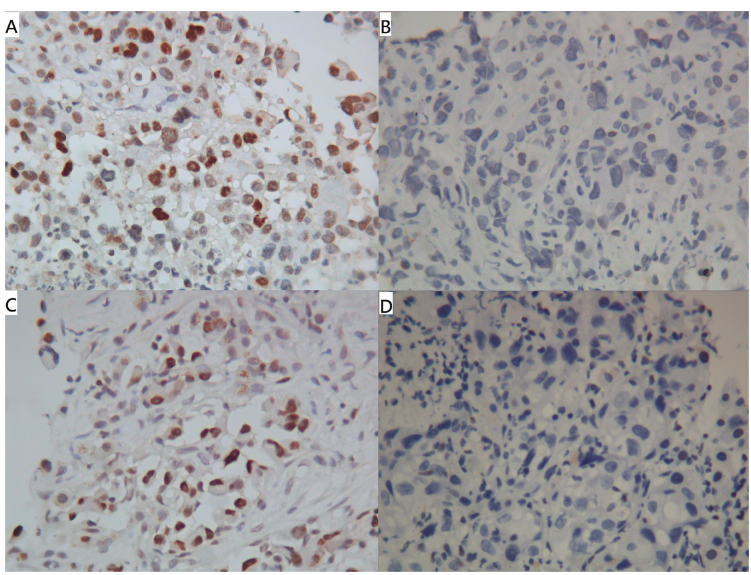
Fig 1. Representative cases of IHC expression (magnification 400X). Cases of IHC expressionwith (A) MDM2+, (B) MDM2-, (C) p53+, and (D) p53- were demonstrated. The positive staining was predominantly nuclear for both MDM2 and p53.